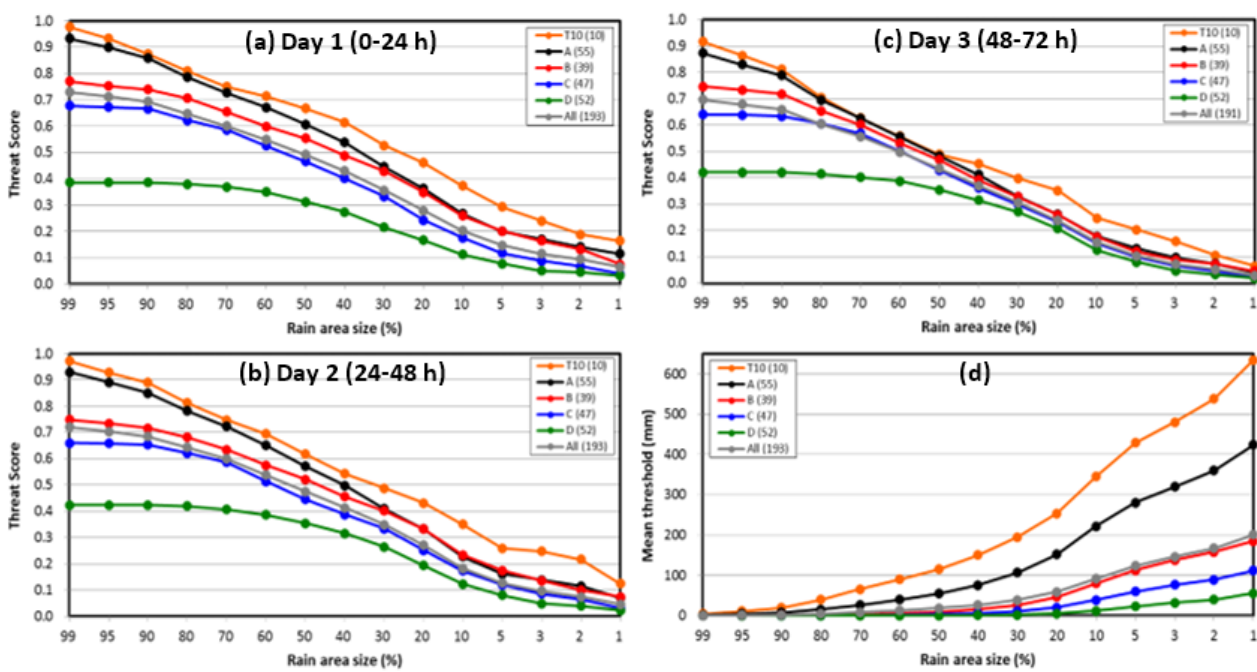
Figure 9. ( a – c ) As in Figure 6a–c, but showing the TS for groups A–D, group T10, and all typhoon events as a function of observed rain-area size (%), instead of rainfall threshold, for ( a ) day 1, ( b ) day 2, and ( c ) day 3. ( d ) As in ( a ), but for mean threshold of the six groups (same for days 1–3). The total numbers of 24 h segments in each group are given in parentheses.